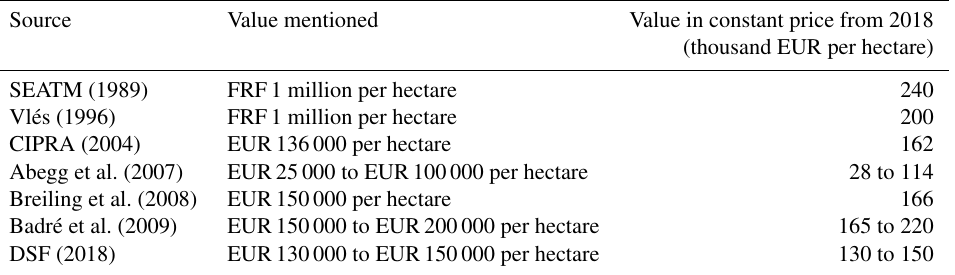
Table 1. Snowmaking investment cost to equip ski slope